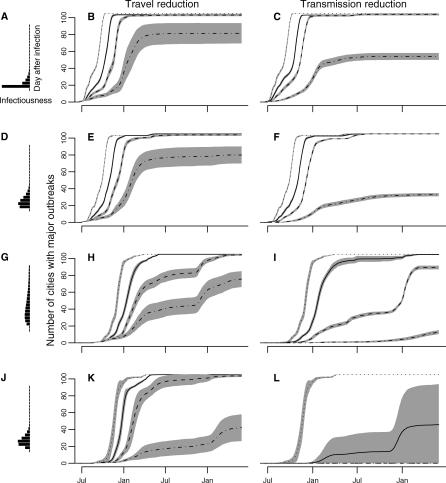
Impact of Interventions: Sensitivity to Disease AssumptionsImpact of interventions under different assumptions about how the probability of being infectious and the degree of infectiousness varies with time since infection (A–I) and with latitude (J–L). Interventions, key, and other details are as in Figure 4, except all interventions occur after 1,000 cases in Hong Kong, and 100 cases elsewhere.(A–C) Variable infectiousness (baseline daily progression and recovery probabilities, but degree of infectiousness declines sharply after day 1 since infection). Mean serial interval = 2.6 d; mean infectious period = 3.0 d; mean latent period = 1.9 d.(D–F) Reduced latent period (constant infectiousness): Mean serial interval = 3.8 d; mean infectious period = 3.4 d; mean latent period = 1.2 d.(G–I) Extended infectious period (constant infectiousness): Mean serial interval = 8.6 d; mean infectious period = 3.9 d; mean latent period = 5 d.(J–L) Baseline parameters (constant infectiousness), but transmission in the tropics set to the mean of that in the temperate region.(A, D, G, and J) Proportion of secondary transmission that occurs 0–20 d after infection. In all cases, no transmission occurs on day 0 and R
0,max = 3.